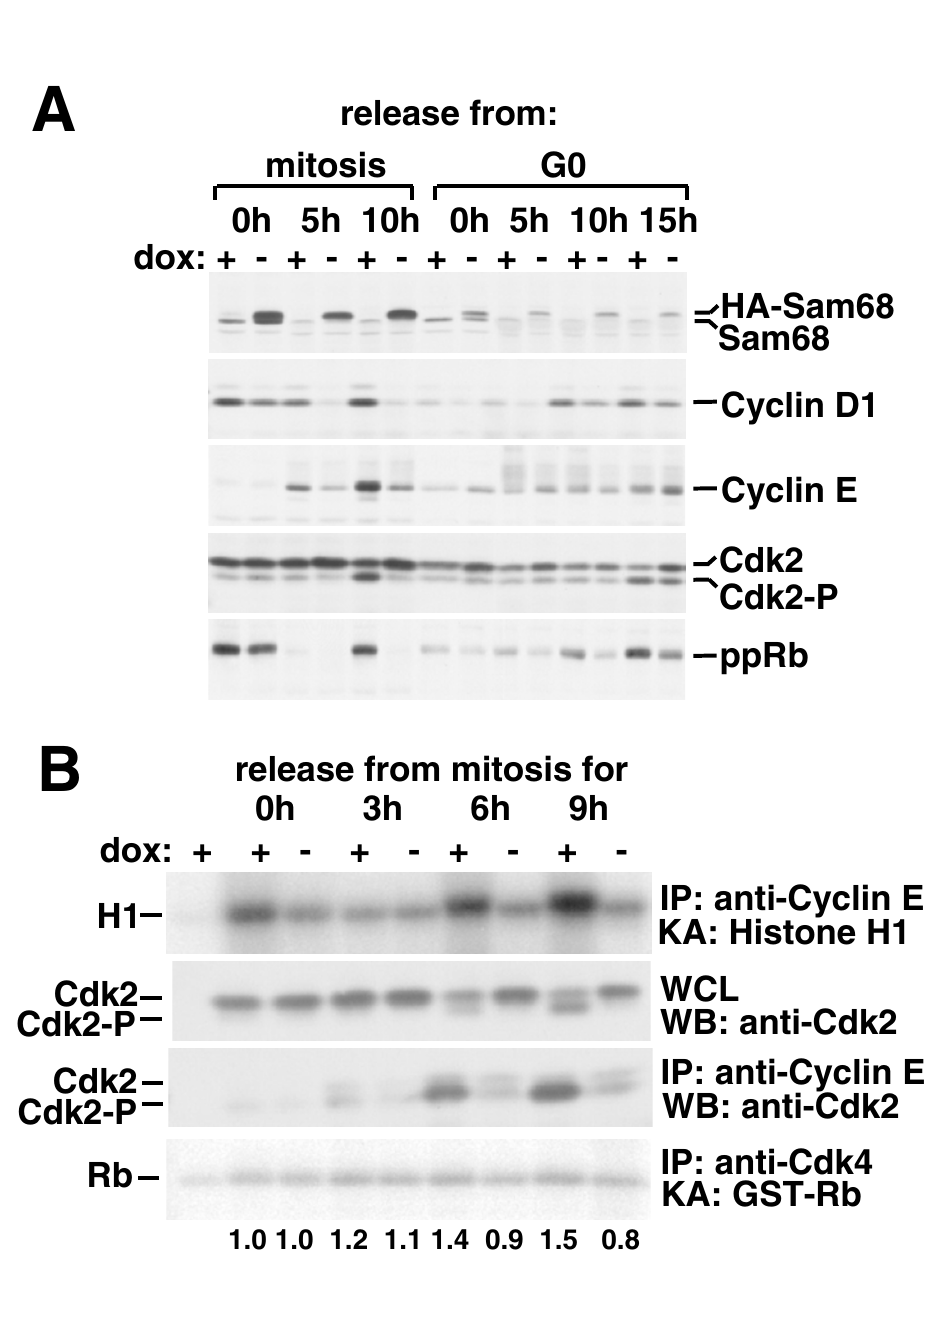
Figure 3 Sam68 overexpression decreases G1 Cdk activities and Rb phosphorylation. A. Cells were synchronized in mitosis by nocodazole treatment or in G0 by serum deprivation and released into G1 by drug removal or serum replacement, respec- tively. At the indicated times after release cells were lysed in 3T3 lysis buffer and immunoblotted with antibodies against Sam68, cyclin D1, cyclin E, Cdk2 or phospho-Rb. B. Lysates from cells released from mitosis for the indicated times were sub- jected to immunoprecipitation with anti-cyclin E or -Cdk4 antibodies. Immunoprecipitates were assayed for in vitro kinase activ- ity (KA) with histone H1 or GST-Rb as substrates, respectively. Indicated below the Cdk4 assay gel are relative 32 P incorporations into Rb per lane, as determined by phosphorimager analysis. Whole cell lysates (WCL) or immunoprecipitates (IP) were also Western blotted (WB) with anti-Cdk2 antibodies. Results are representative of three separate